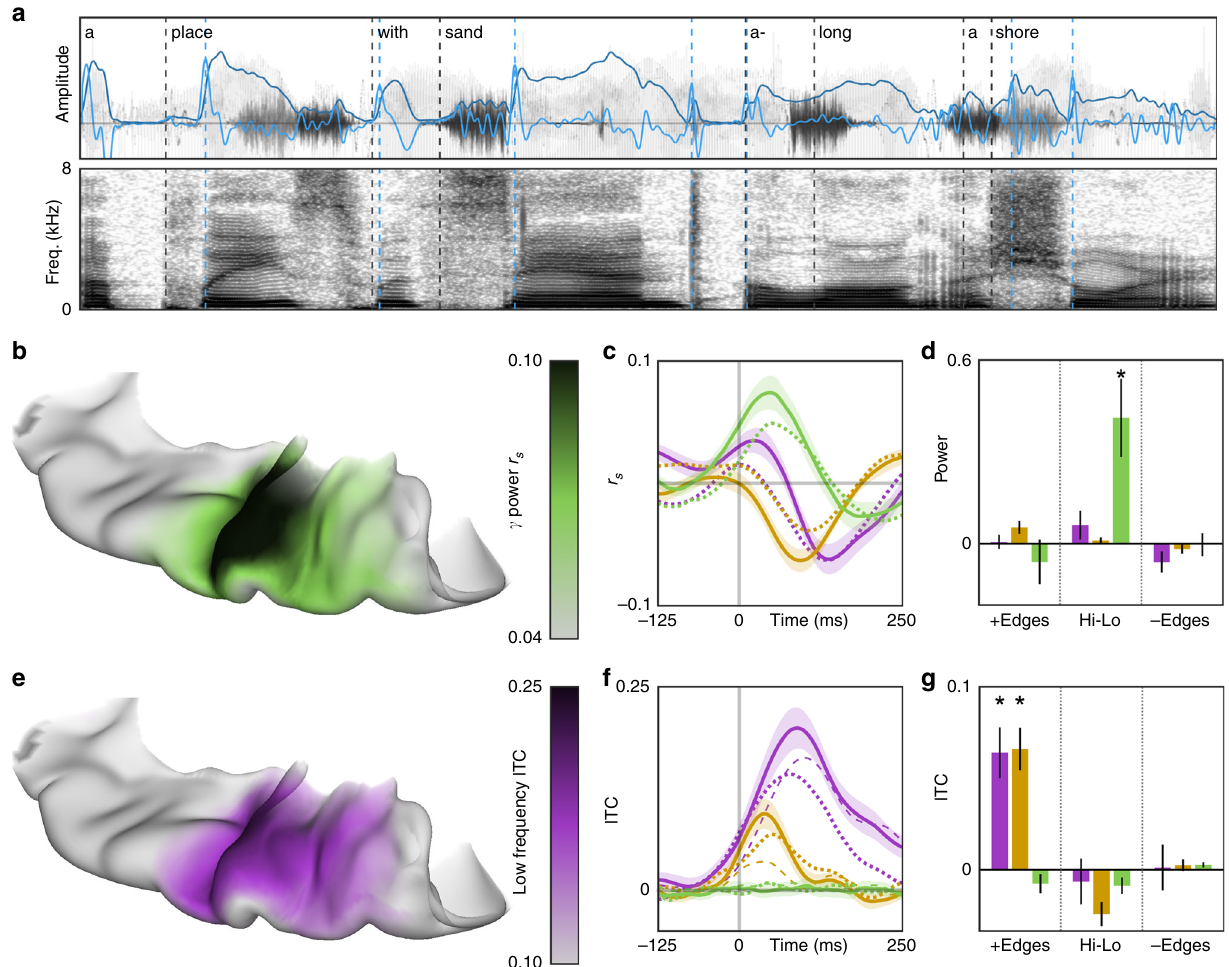
Fig. 5 Essential feature encoding of speech in early auditory cortex. Edge detection and envelope tracking during natural language speech occurs focally in early auditory cortex. a Patients ( n = 25) listened to short sentences describing common objects, an example of which is represented here as a time series (top) and a spectrogram (bottom). Two features were extracted from each stimulus: acoustic envelope (light blue) and acoustic edges (dark blue). For comparison, syllabic onsets (black) were also demarcated. b The peak lagged Spearman ’ s correlation between acoustic and high-gamma envelopes and e the average low-frequency ITC following an acoustic edge were computed for all electrodes in superior temporal gyrus. These measures were mapped onto a standard MNI atlas, revealing acoustic encodings limited to early auditory cortex. c The encoding of acoustic envelope for speech perception was further explored by cross correlation with low frequency (purple), beta (yellow), and high-gamma (green) amplitudes. The effect size was slightly reduced for reversed speech (dotted lines). Shaded area represents ±1 standard error of the mean. f Acoustic edges were better encoded by low-frequency phase than syllabic onsets (dashed lines). d , g In 21 patients with depth electrodes in Heschl ’ s gyrus, we directly compared the power and phase encodings of discrete acoustic signal events: the difference between 50 ms pre- and post-edge windows, as well as the difference between 50 ms windows centered on envelope peaks and valleys. Signi fi cance was evaluated at the group level using the Wilcoxon signed-rank test (* p < 0.001, black bars represent ±1 standard error of the mean). Phase in low frequencies encoded only encoded positive acoustic edges. Power in high-gamma frequencies only encoded the raw envelope highs and